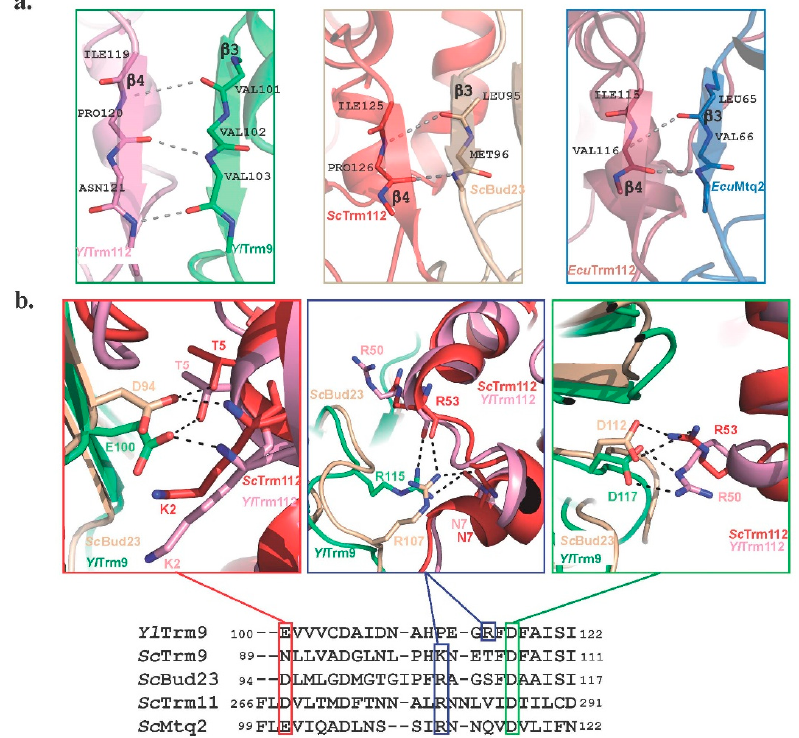
Figure 6. Comparison of the Trm112 ‐ MTase interfaces. ( a ) Ribbon representation of the β ‐ zipper interaction between Trm112 and MTases. Hydrogen bonds formed between main chain atoms from both partners are depicted by grey dashed lines. ( b ) Comparison of Sc Bud23 ‐ Trm112 and Yl Trm9 ‐ Trm112 structures reveals conserved hotspots involved in complex formation. A structure ‐ based sequence alignment of Yl Trm9 and of the four S. cerevisiae MTases interacting with Trm112 is shown in the lower panel. Only a small region of these MTases is shown for the sake of clarity.